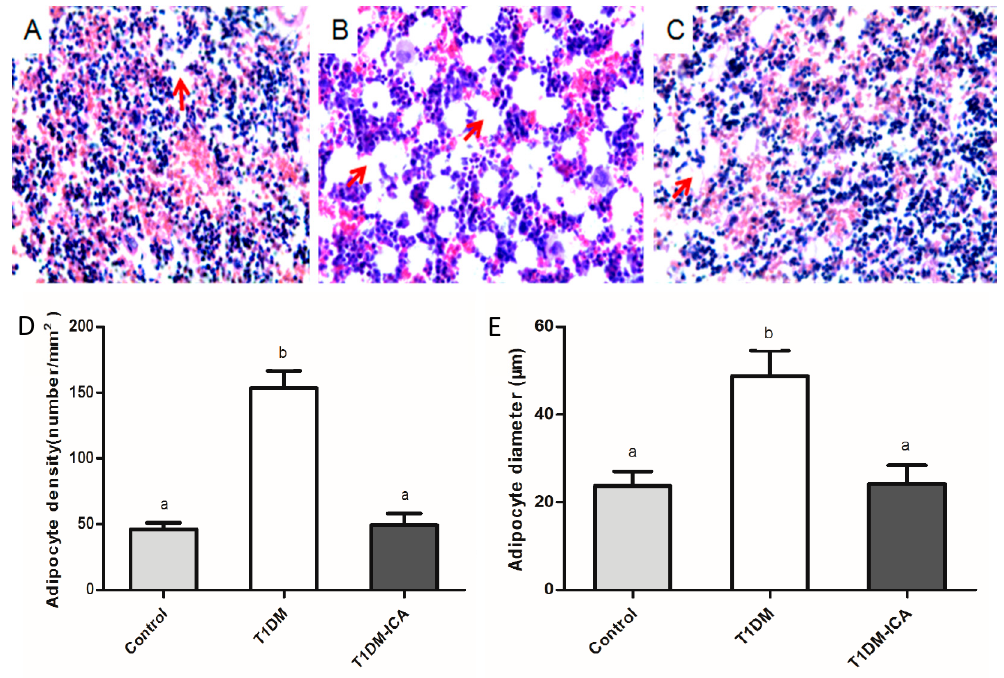
Figure 6. Bone marrow adipocyte and their density and diameter in all experimental groups. ( A ) The tiba bone marrow of control rat; ( B ) the tiba bone marrow of T1DM rat; ( C ) the tiba bone marrow of T1DM-ICA rat; hematoxylin and eosin staining, magnification: 400 × ; ( D ) adipocyte density of tibia bone marrow in each group; ( E ) mean adipocyte diameter of tibia bone marrow in each group. Values are presented as means ± SD. Different letters indicate statistically significant difference ( p < 0.05). Red arrows point to adipocytes.